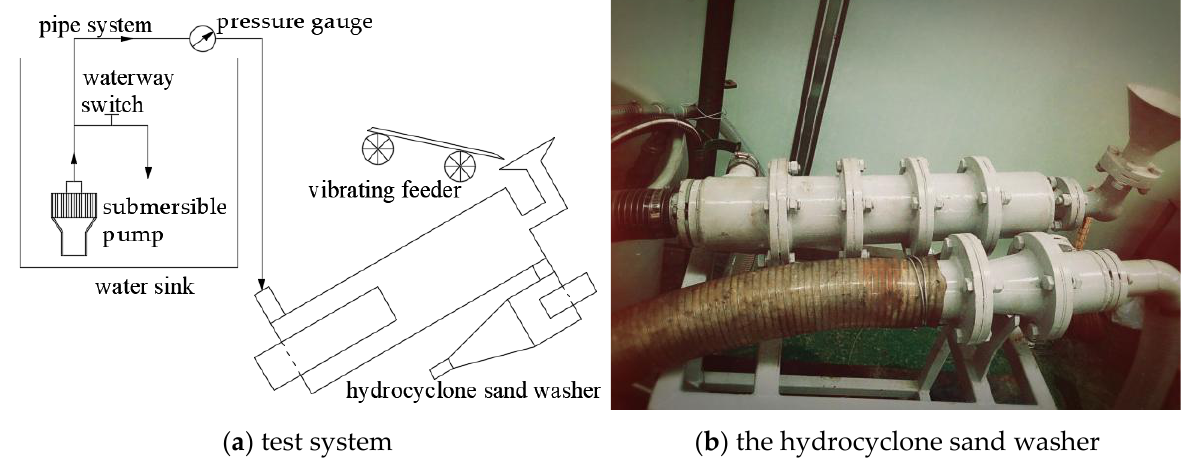
Figure 4. Scheme of the test system and photo of the hydrocyclone sand washer.